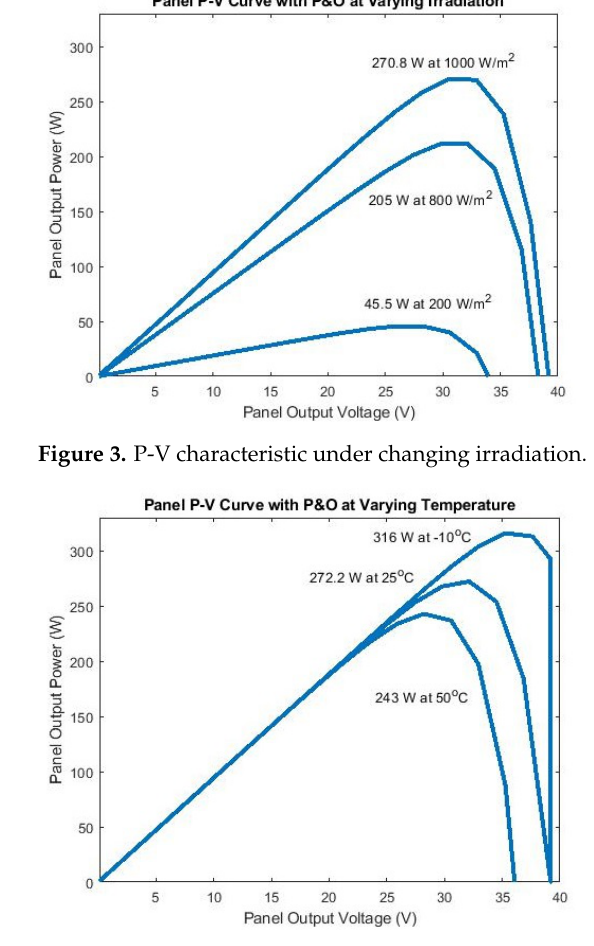
Figure 4. P-V characteristic under changing